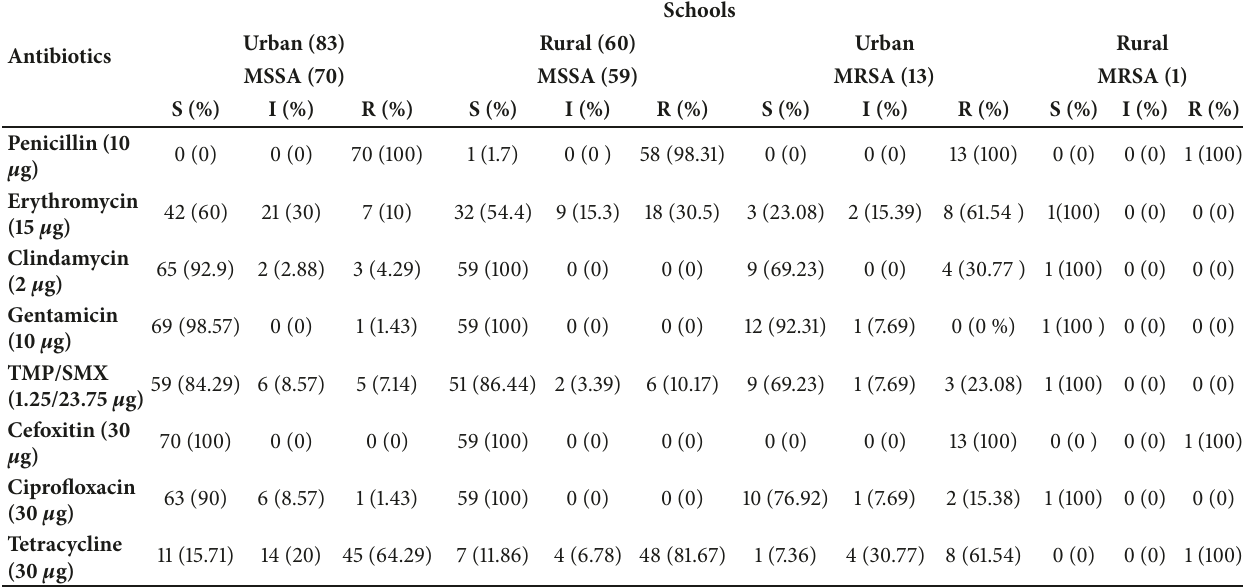
Table 3: Antibiotic susceptibility patterns of Staphylococcus aureus isolates in Gondar town, Northwest Ethiopia,